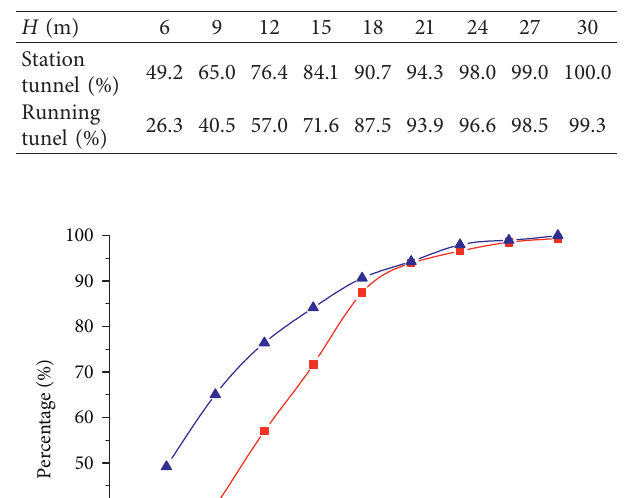
Figure 12: The change of ground settlement with different rock cover thicknesses. Table 10: The GSEA ratio of metro tunnel under different buried depths.